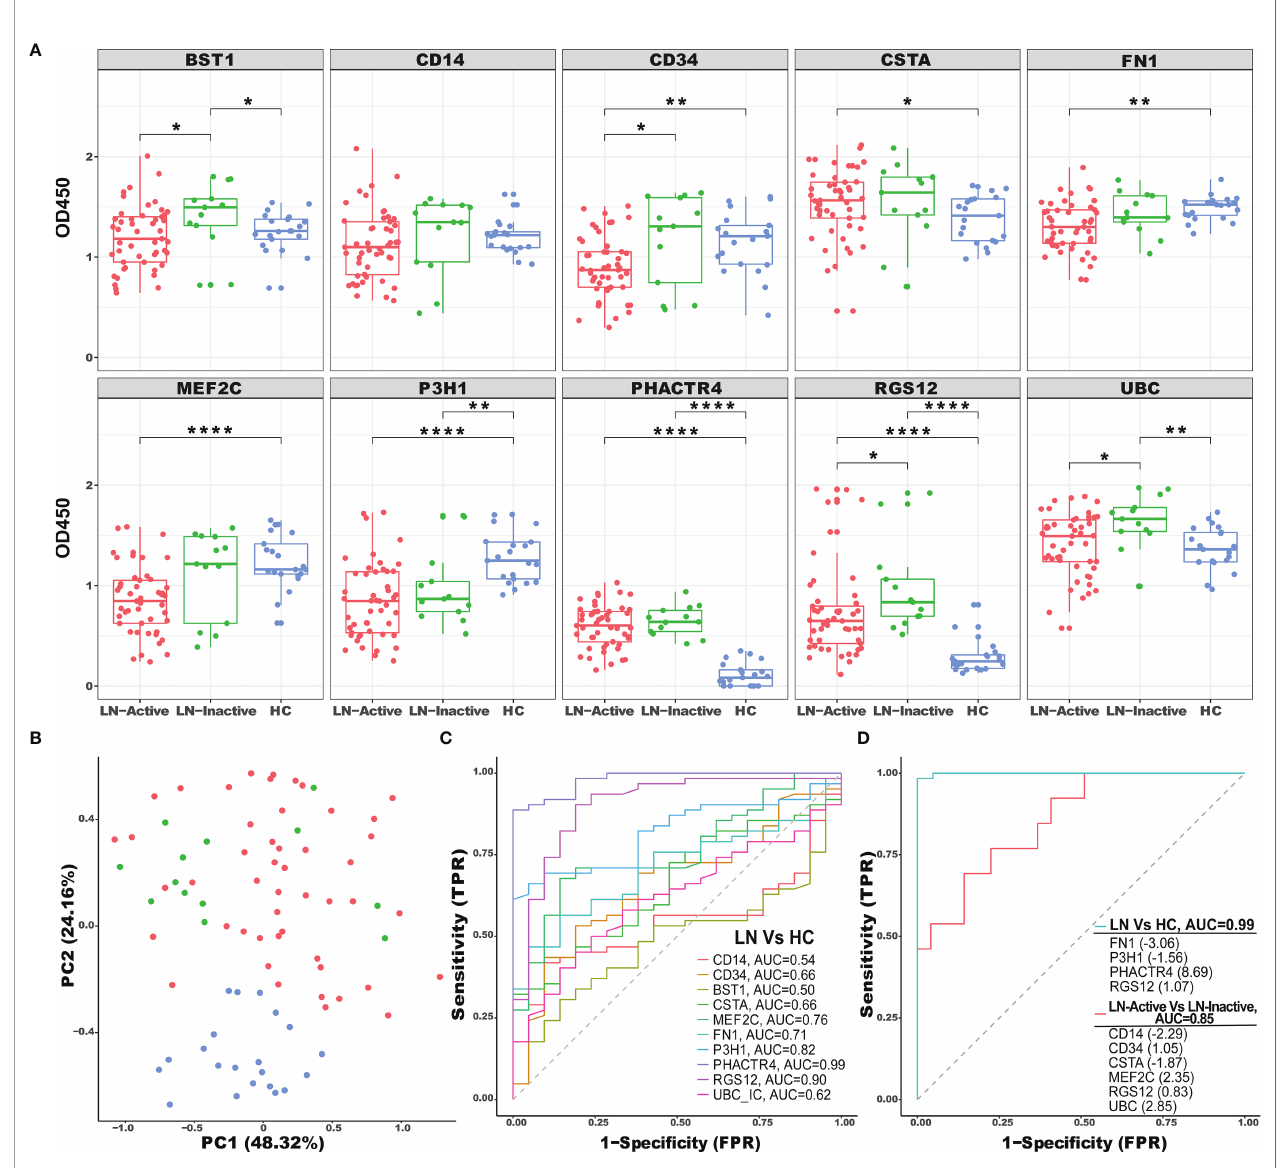
FIGURE 4 | ELISA validation of selected ICx in an independent cohort of LN patients. (A) A total of 83 serum samples from healthy controls (N = 21, blue), inactive LN (N = 13, green), and active LN (N = 49, red) were tested by sandwich ELISA for immune complex levels of BST1, CD14, CD34, CSTA, FN1, MEF2C, P3H1, PHACTR4, RGS12, and UBC. Asterisks designate the level of statistical signi fi cance: *p < 0.05, **p < 0.01, ****p < 0.0001, using the Wilcoxon test. (B) Principal component analysis (PCA) of 10 ICx among HC, inactive LN, and active LN individuals. The two fi rst principal components (PC1, PC2) were plotted. (C) The discriminatory abilities of the 10 ICx in distinguishing LN patients from healthy control were examined using ROC analysis. (D) Using LASSO regression analysis, the ICx were combined into panels to distinguish LN patients from healthy control or active LN from inactive